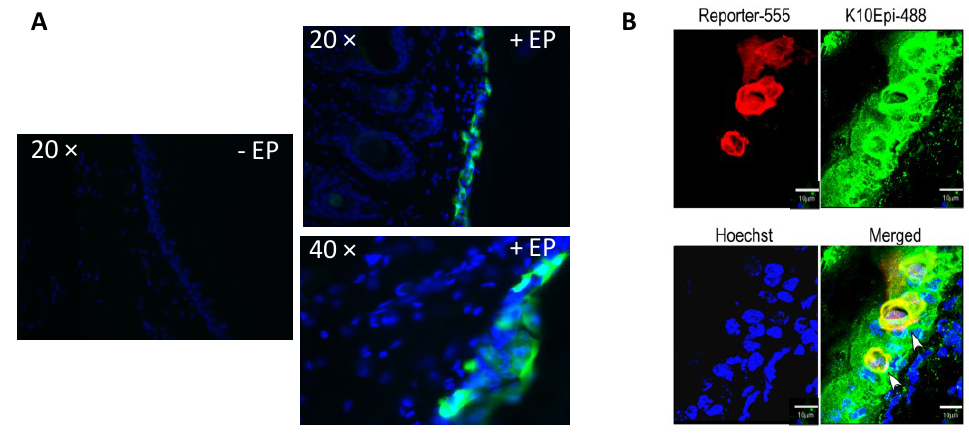
Figure 3. Histological analysis reveals reporter gene expression localized to cells in the epidermis. Histological analysis of GFP and red fluorescent protein (RFP) expression after ID plasmid administration followed by SEP in guinea pig skin. ( A ) GFP treated skin biopsies were removed 4 h post treatment, cryosectioned, DAPI stained and visualized using fluorescence microscopy (20× and 40×). An injection only control (no EP) is also shown; ( B ) RFP treated skin biopsies were removed, cryosectioned, stained with an antibody against K10 (a keratinocyte cell surface marker), Hoechst stained and visualized using confocal